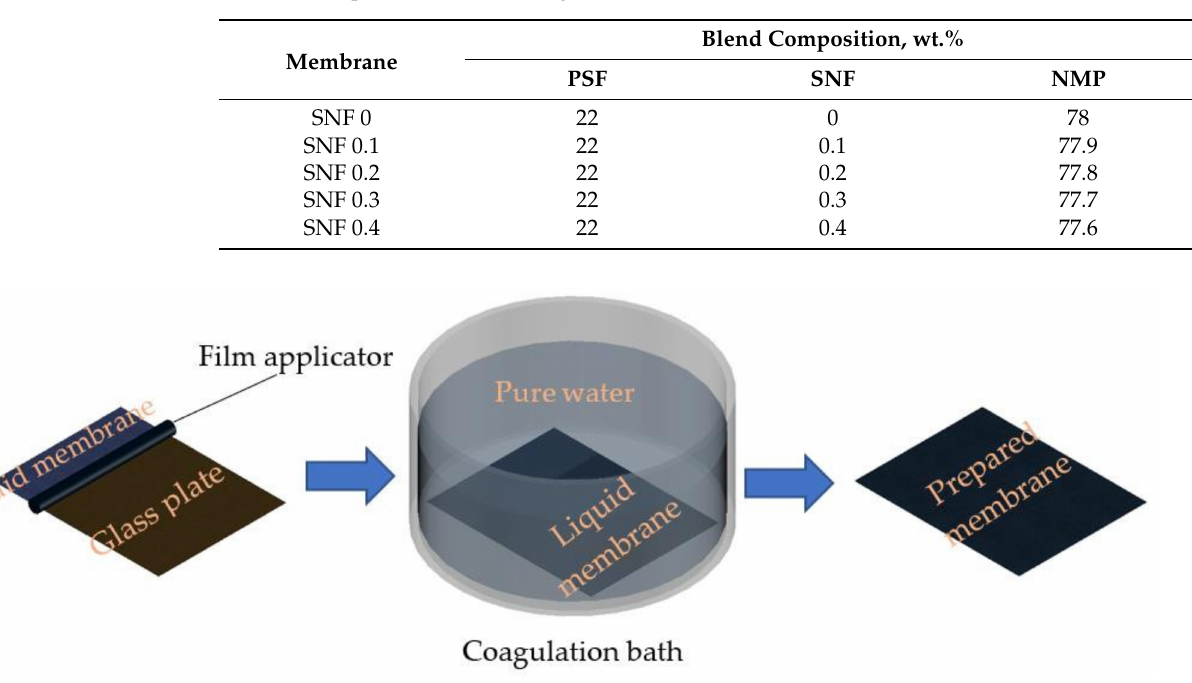
Figure 2. Membrane gelatinization